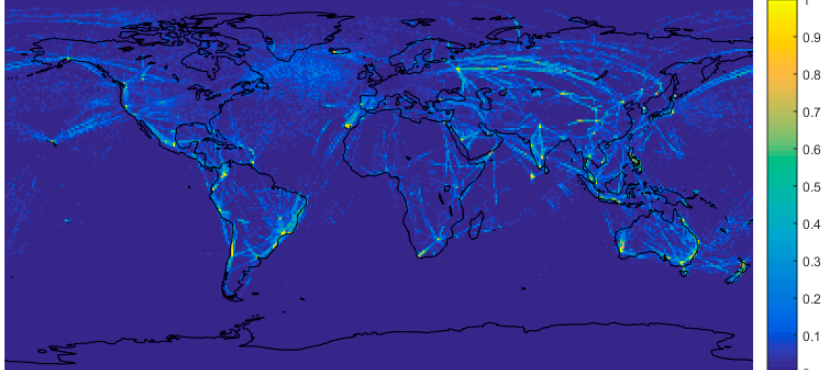
Figure 2. Aircraft traffic density distribution.